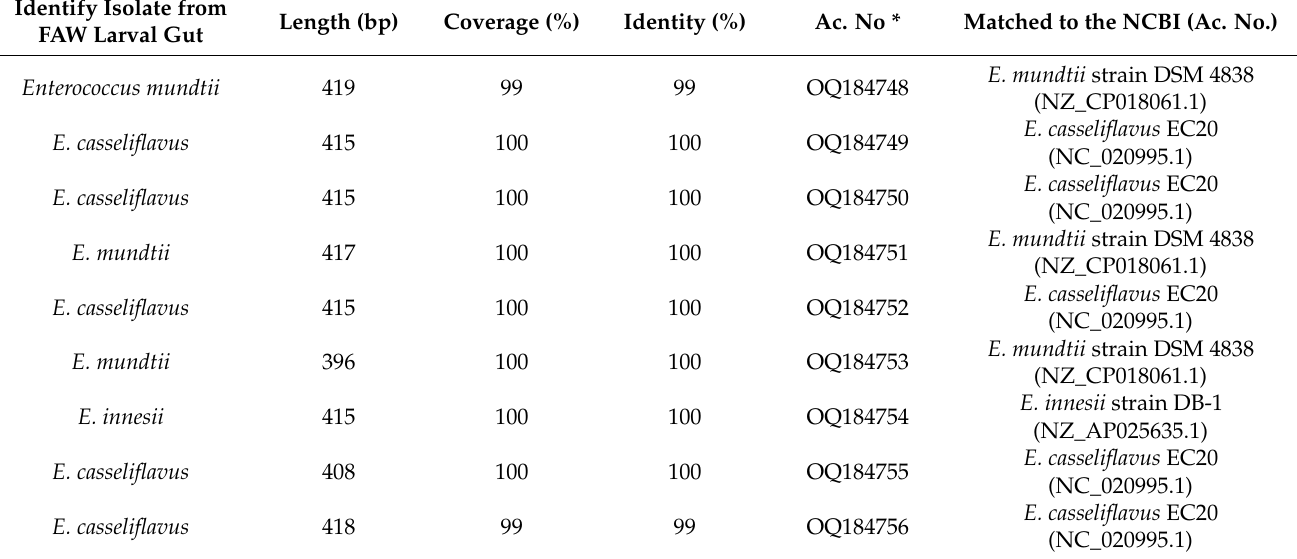
Table 3. Information on main bacterial species from FAW gut microbial culture. Identify Isolate from Length (bp) Coverage (%) Identity (%) Ac. No * Matched to the NCBI (Ac. FAW Larval Gut